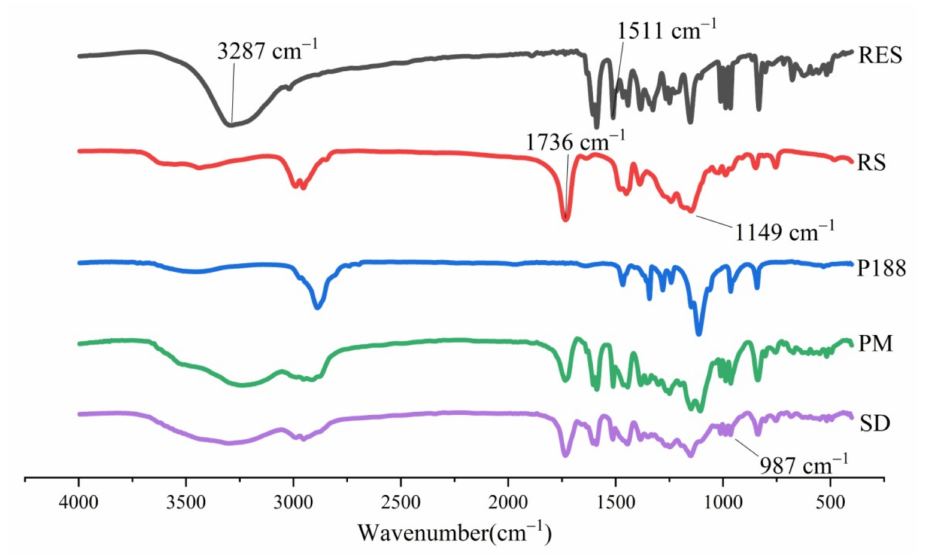
Figure 11. IR spectrum of RES, carriers, PM, and